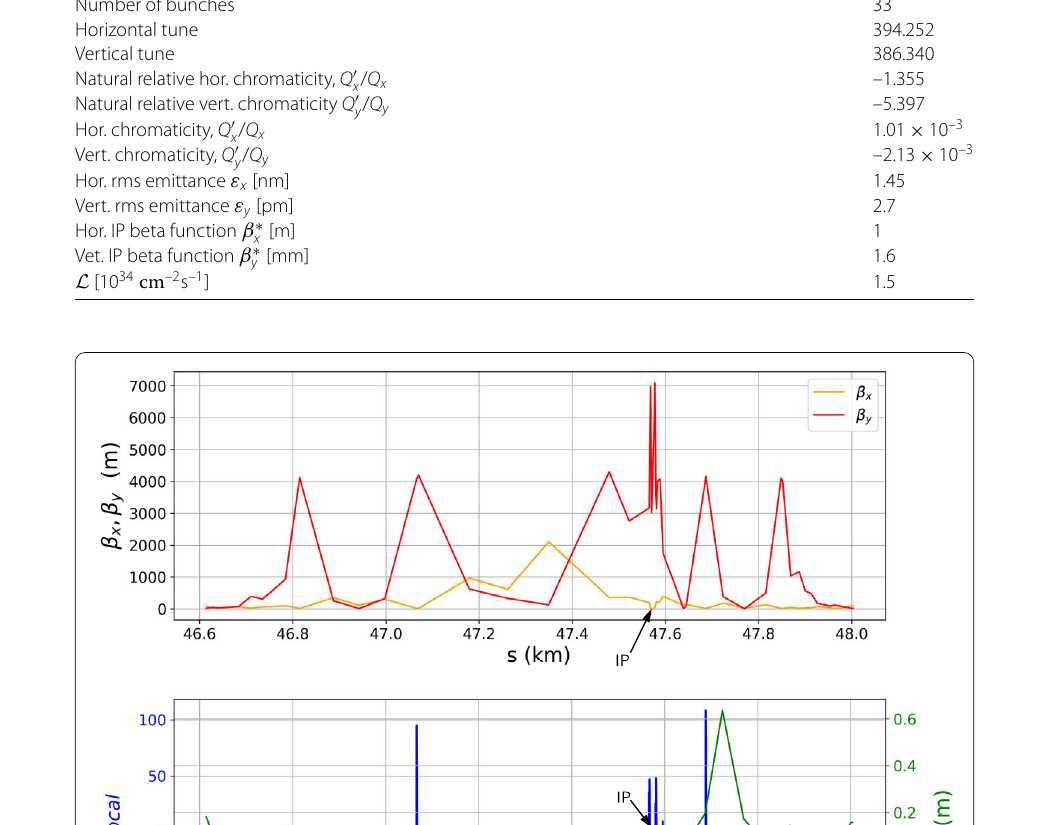
Table 1, assuming collisions in two of the interaction points. The design optical functions around the interaction region (IR) are shown in Fig.